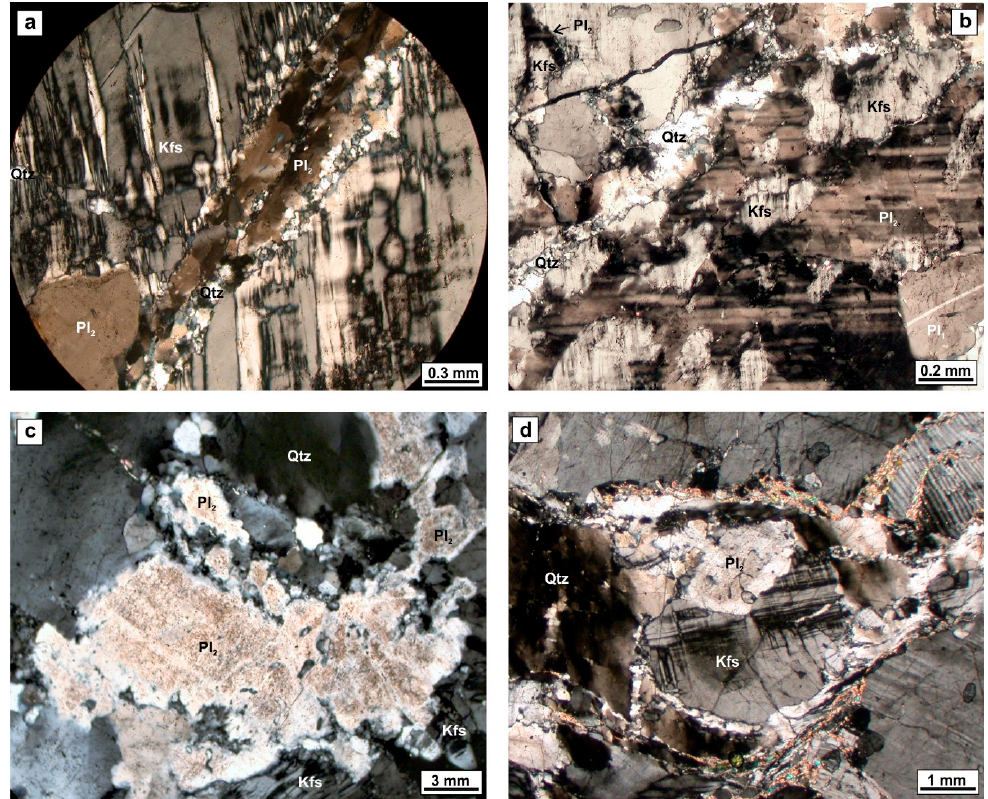
Figure 5. Relationships between shearing and infiltration metasomatism in metasomatic trondhjemites (crossed polars). Abbreviations: Pl, plagioclase; Qtz, quartz; Kfs, K-feldspar. ( a , b , c ) growth of secondary plagioclase after grain size reduction in the original granite; ( d ) growth of myrmekitic plagioclase at expense or relic feldspar porphyroclast. Figures a, d are modified after [47].